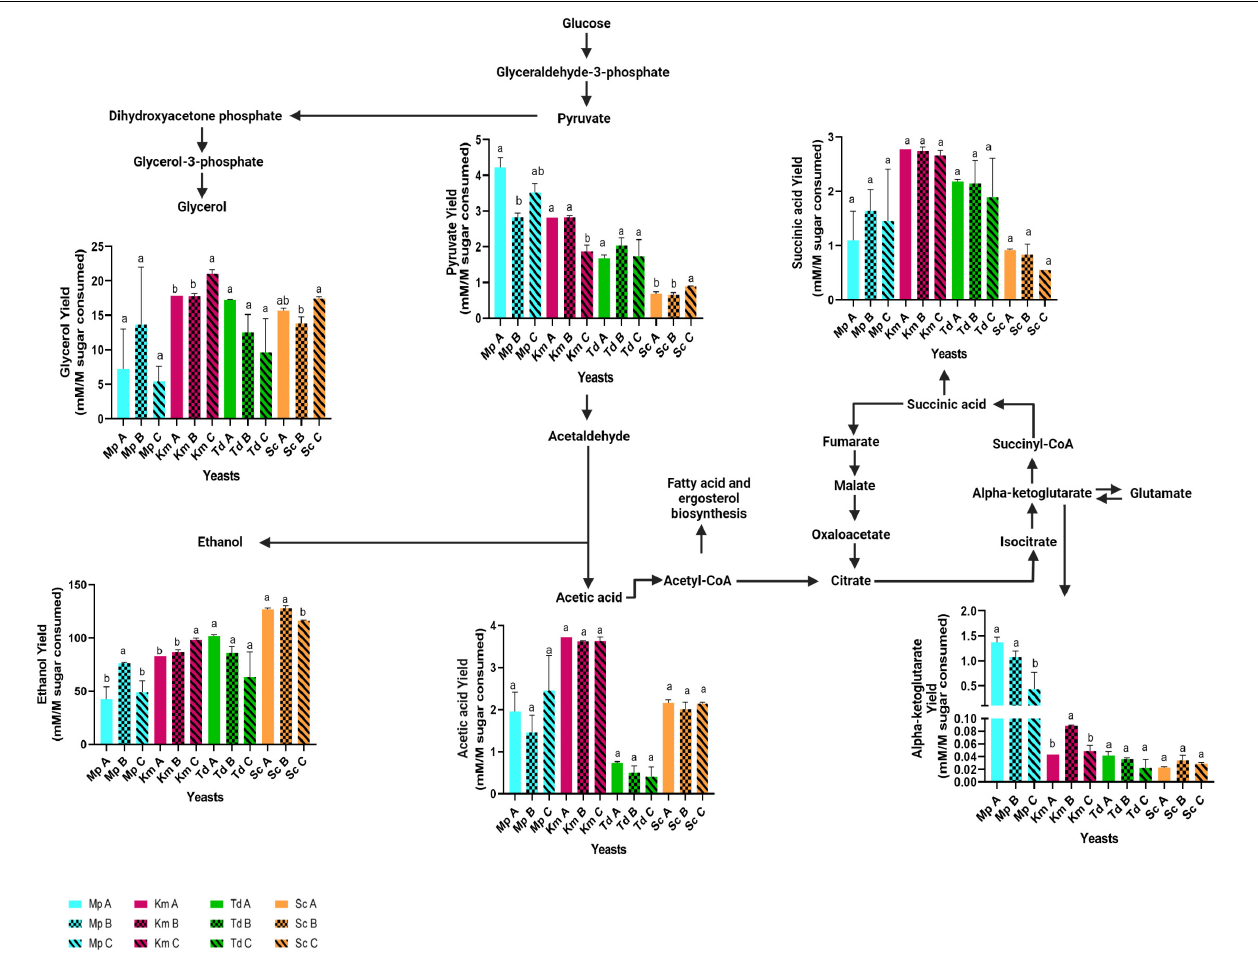
FIGURE 3 | Fermentation derived metabolites yields in media containing different lipid combinations. Samples were harvested when fermentations were terminated and yields were calculated by normalizing the metabolites produced by sugar consumption (mM/M sugar consumed). Blue bars- M. pulcherrima in Medium A (Mp A), B (Mp B) and C (Mp C). Pink bars— K. marxianus in Medium A (Km A), B (Km B) and C (Km C). Green bars— T. delbrueckii in Medium A (Td A), B (Td B) and C (Td C). Orange bars— S. cerevisiae in Medium A (Sc A), B (Sc B) and C (Sc C). Results obtained for treatments with the same letters are not statistically significant ( p <